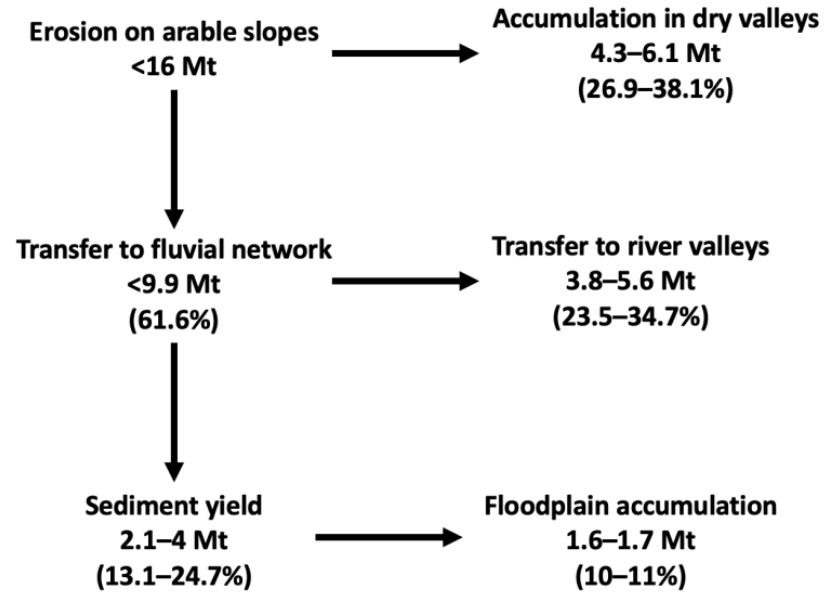
Figure 9. Preliminary sediment budget of Plava River for 1986 – 2012.